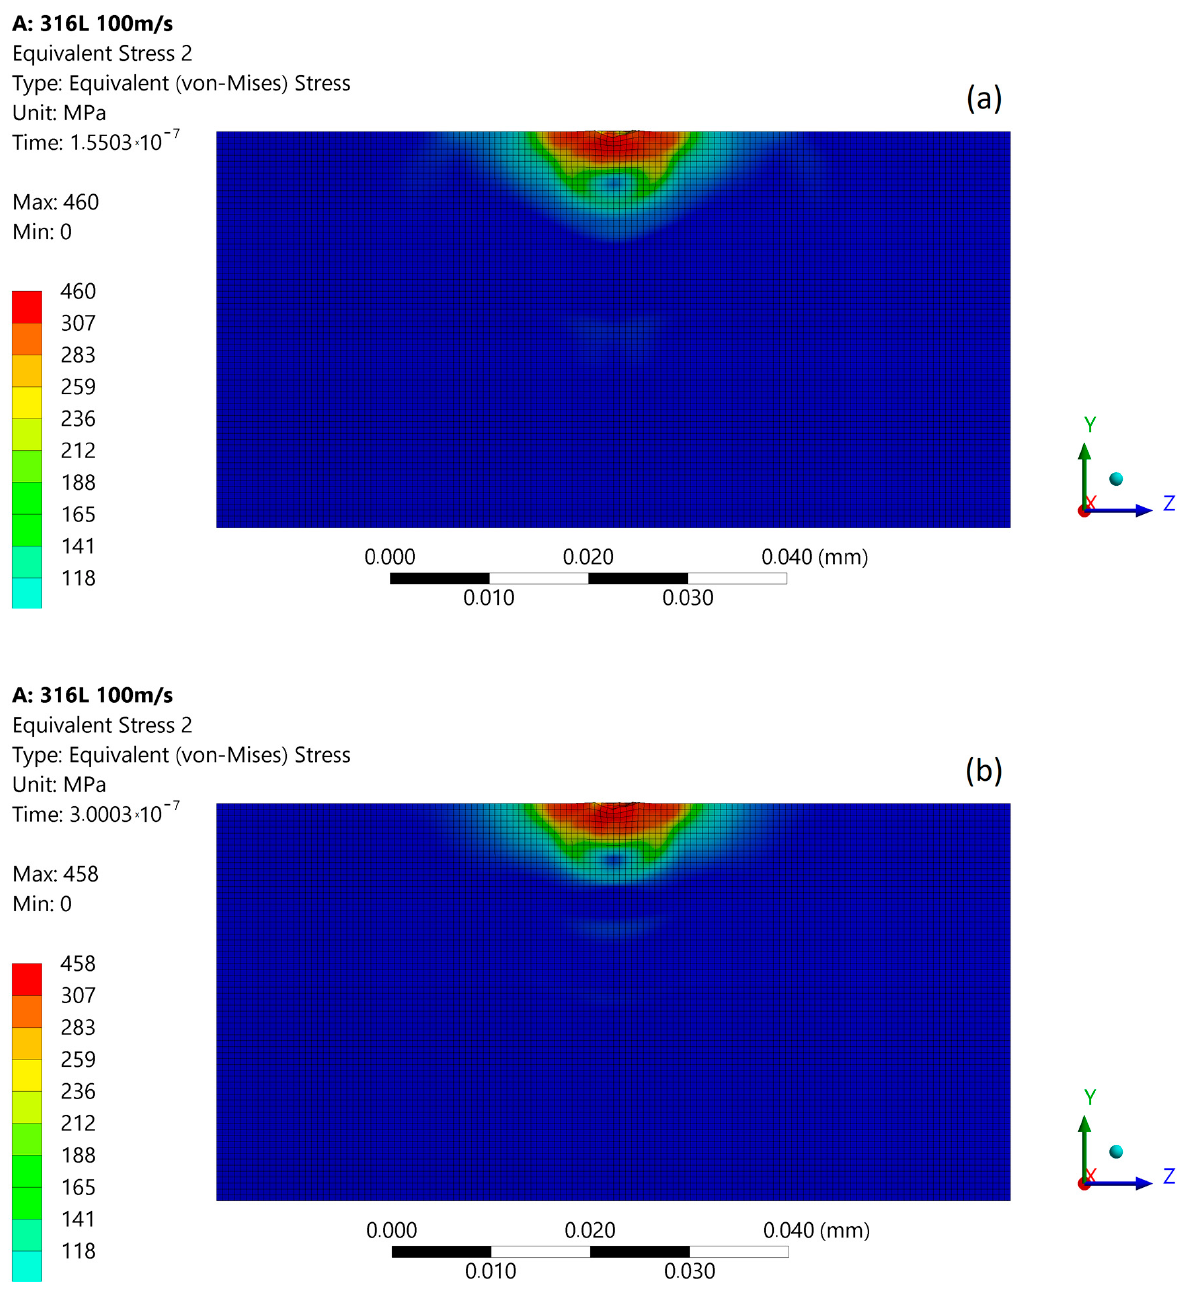
Figure 8. Exceeded yield stress zone (over 307 MPa—red) of 316L stainless steel: ( a ) after first micro-jet impact; ( b ) after subsequent micro-jet impact; at 100